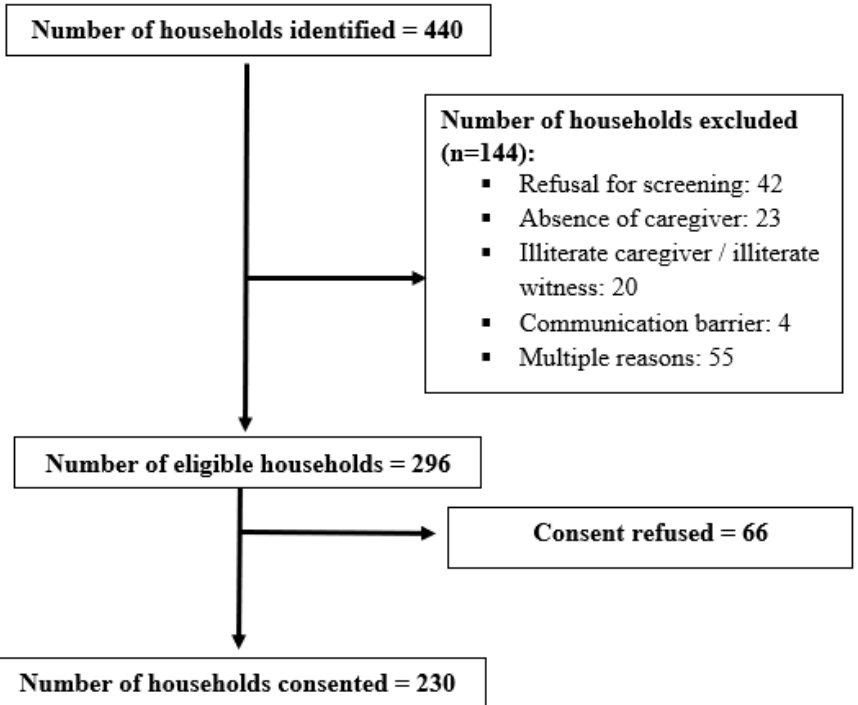
Figure 2. Participants tracking and eligibility screening.